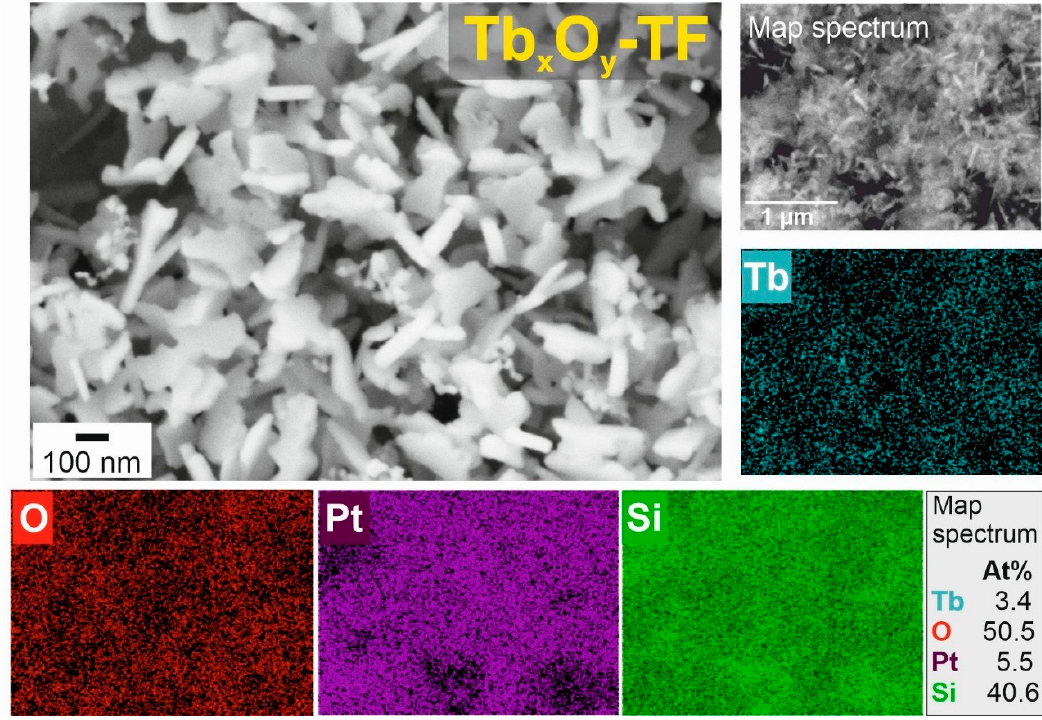
Figure 10. SEM surface microstructure images and EDS elemental mapping of Tb x O y -TF thin film.